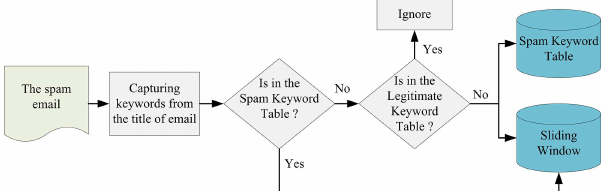
Fig 2. The incremental learning of spam keywords of the Sliding